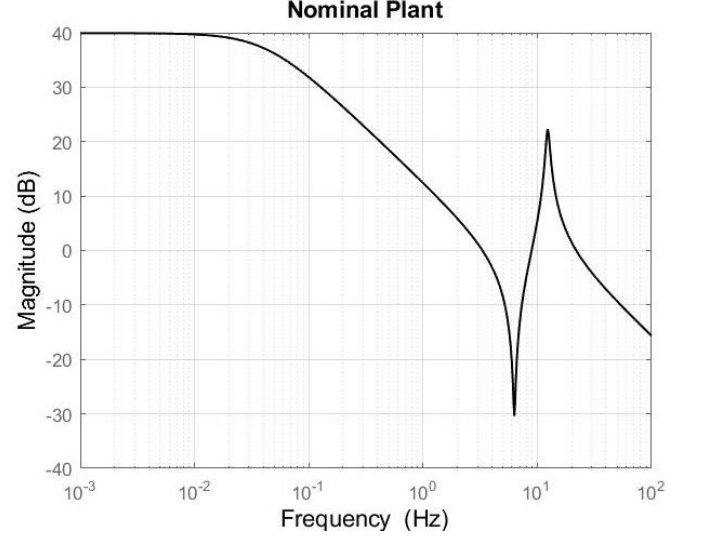
Figure 6. G pm ( s ) Nominal Plant.